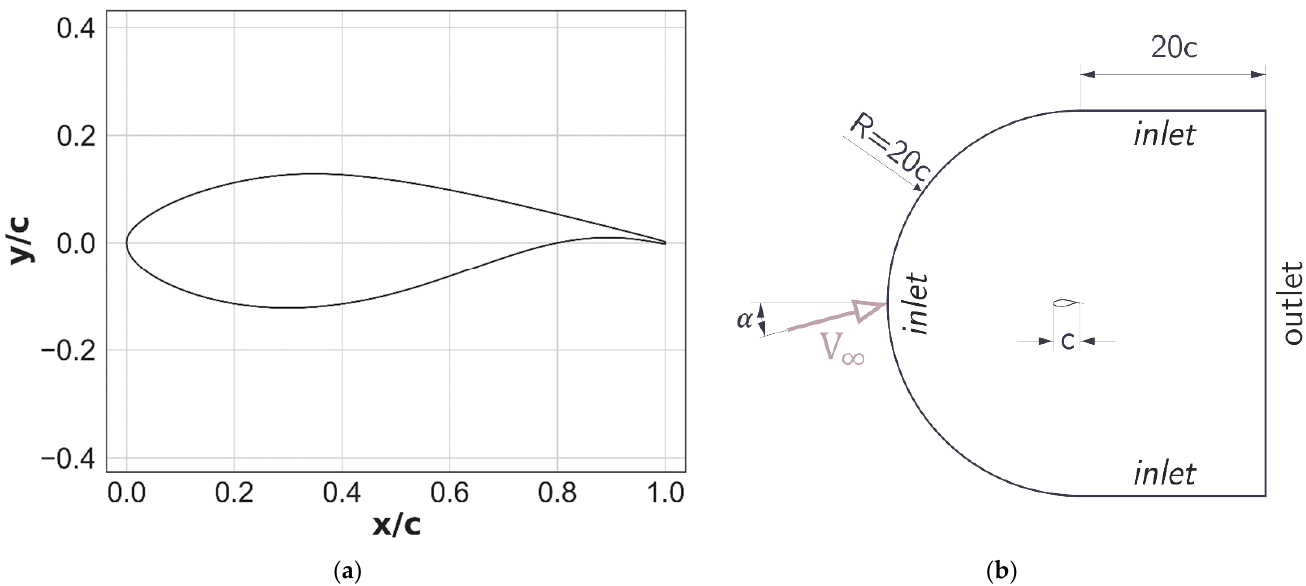
Figure 1. Numerical model: ( a ) DU-91-W2-250 airfoil; ( b ) computational domain and boundary conditions.